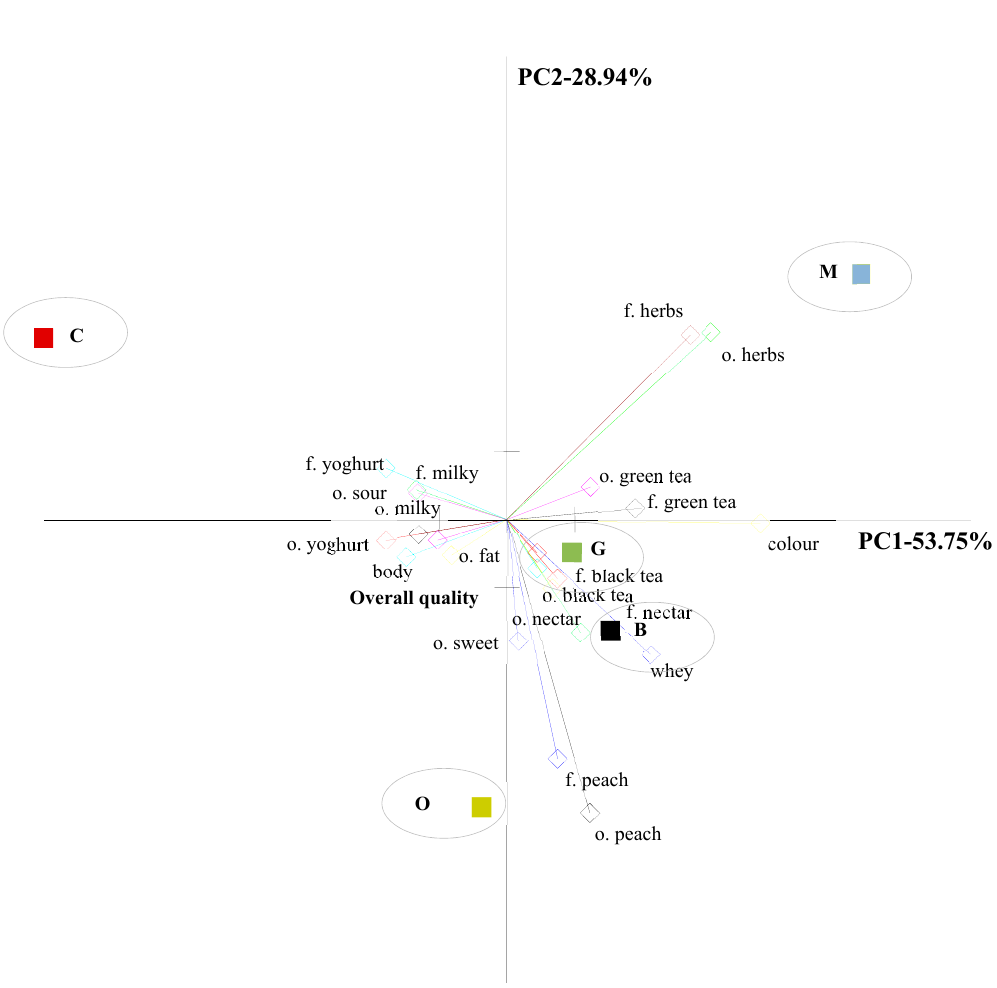
Figure 4. Similarities and di ff erences in the sensory quality of yoghurt samples. C—Control, G—Green tea, B—Black tea, O—Oolong tea, M—Lemon balm (PCA) (f-flavour, o-odour).